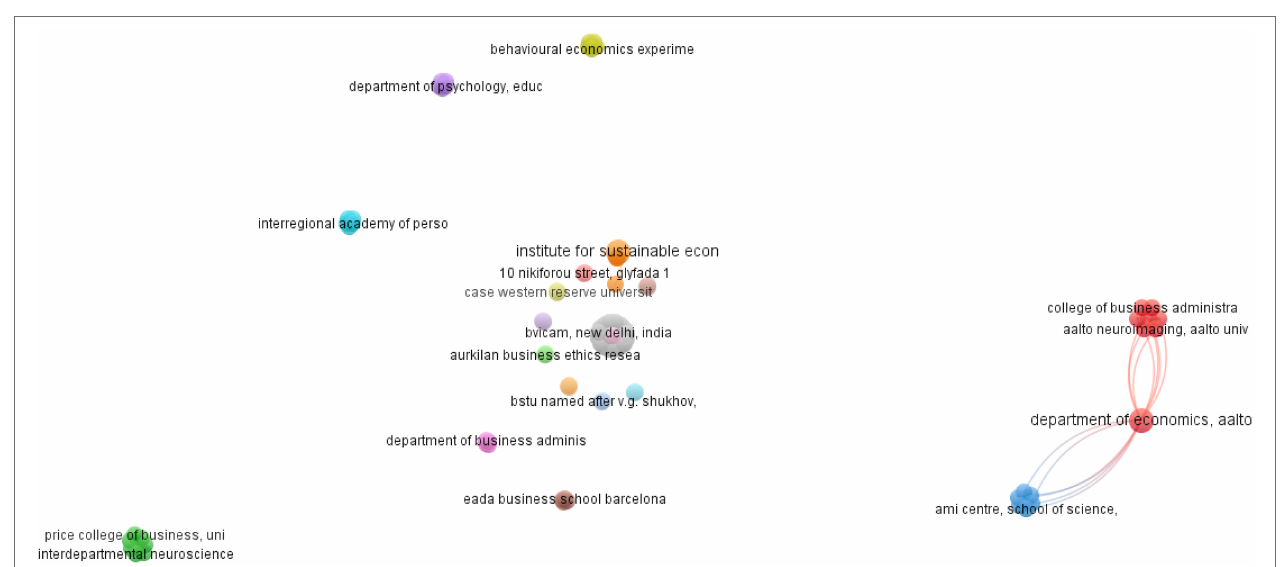
FIGURE 3 | Network of institutional collaboration in neuroentrepreneurship research.